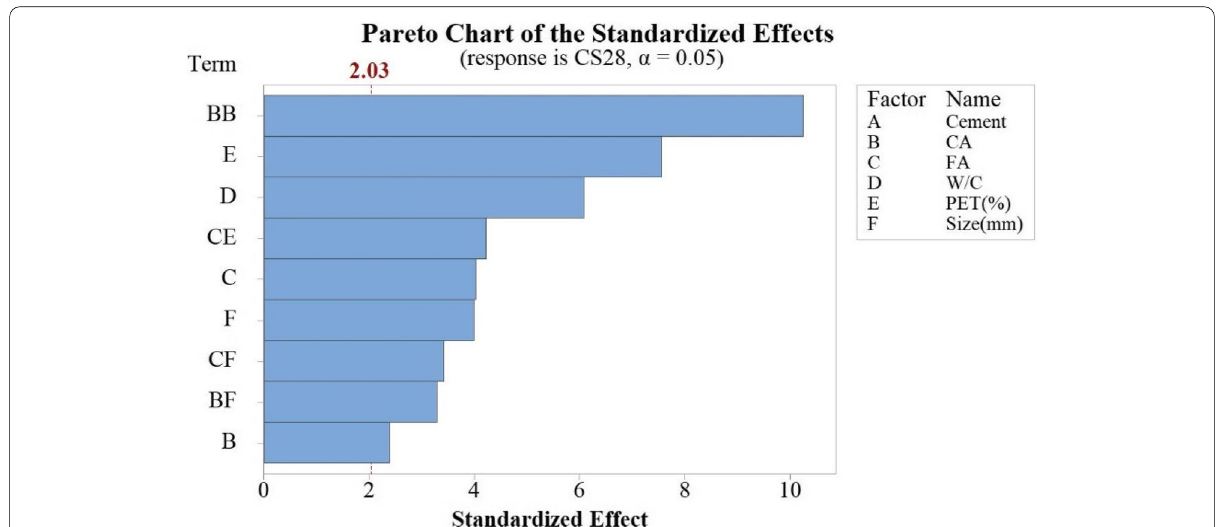
Fig. 1 Pareto Chart of PET-CA